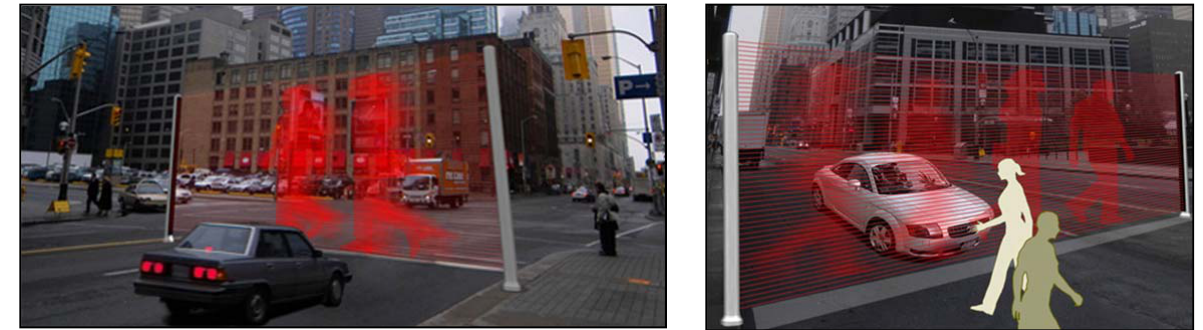
Figure 6. Pedestrian crossing with laser projection systems.